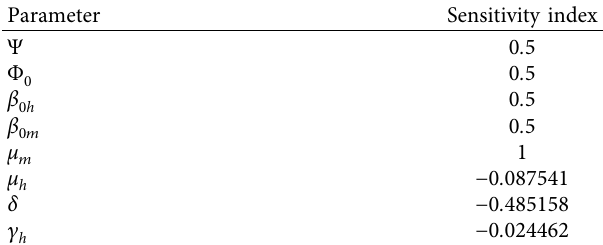
Table 2: Sensitivity indices of parameter.